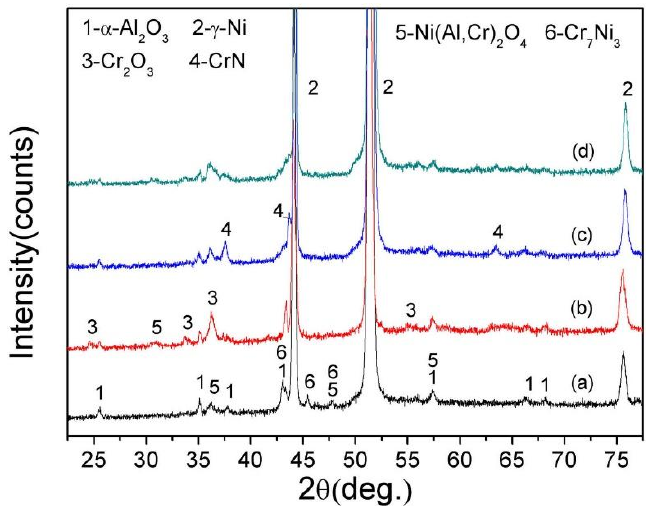
Figure 4. XRD patterns of ( a ) K417/Ni+CrAlYSiN, ( b ) K417/CrN/Ni+CrAlYSiN, ( c ) K417/AlN/Ni+CrAlYSiN and ( d ) K417/TiN/Ni+CrAlYSiN coating systems after 100 h oxidation at 1000 °C in air.